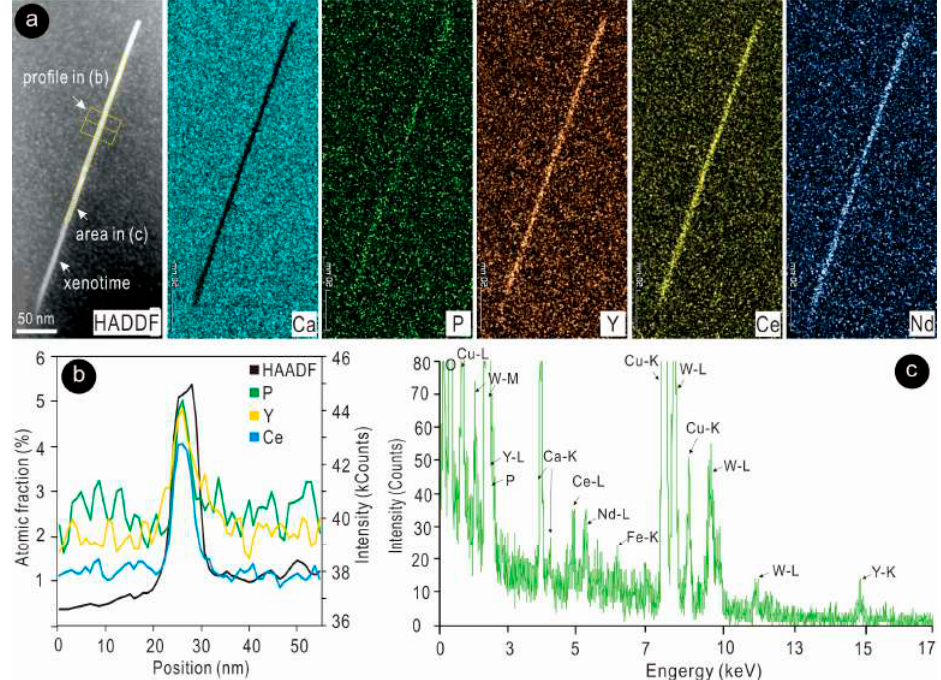
Figure 13. EDS STEM maps ( a ), intensity profile ( b ), and spectrum ( c ) showing two needles of xenotime-(Y) in scheelite-powellite from the zoned grain shown in Figure 9g. Location of profile and area for spectrum are marked in ( a ). The Cu signal is from the TEM grid.